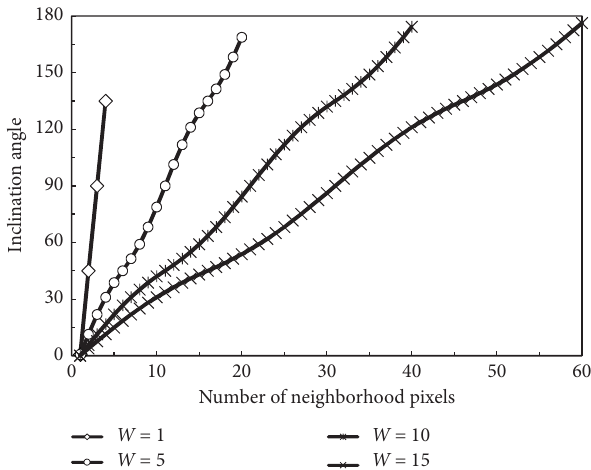
Figure 3: Inclination angles vs. number of neighborhood